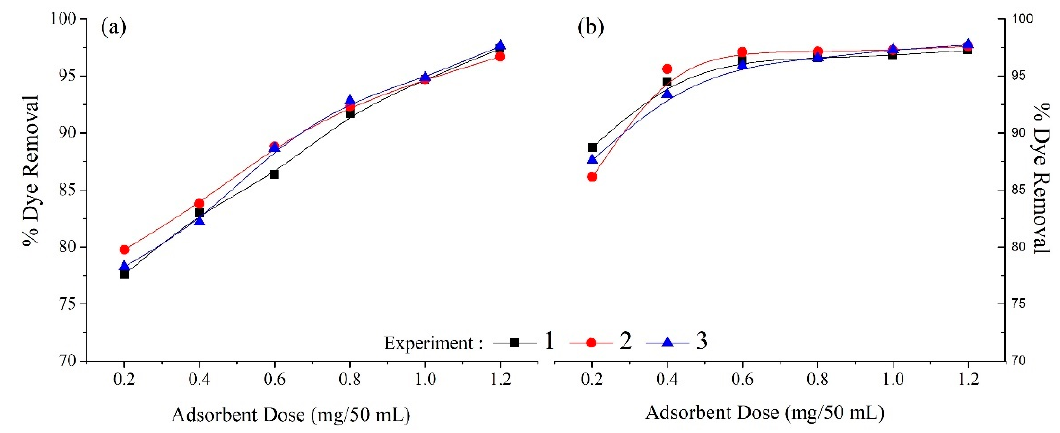
Figure 7. ( a ) Effect of adsorbent dosage on Basic Navy Blue 2RN dye removal. ( b ) Effect of adsorbent dosage on Drimaren Yellow CL-2R dye removal. Adsorbate concentration 50 mg/L. pH (cationic) = 6, pH (anionic) = 2.